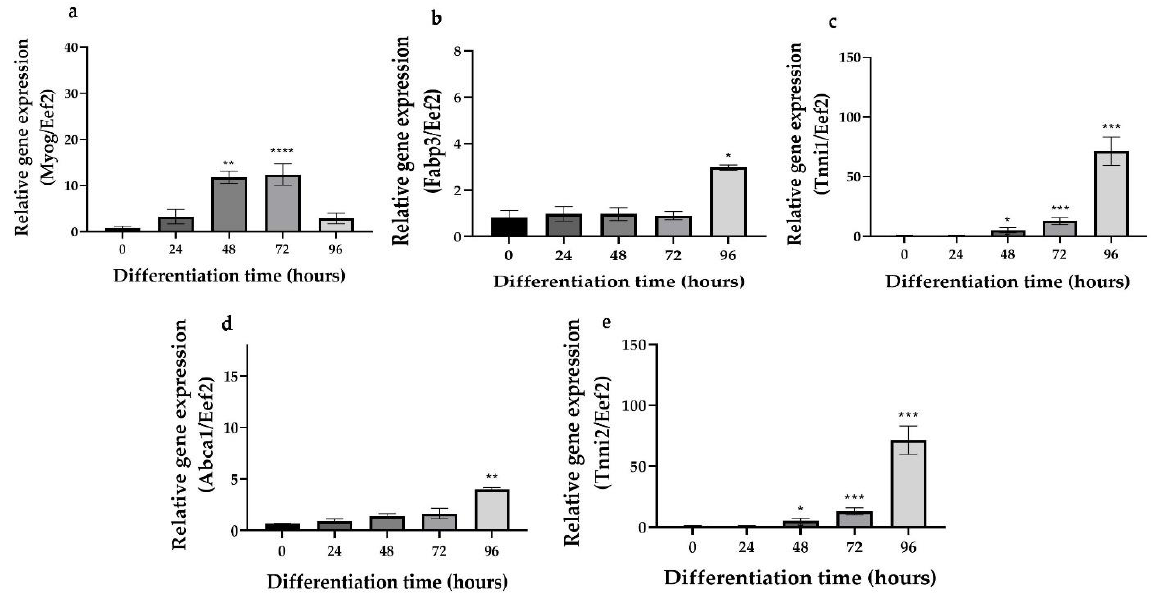
Figure 1. Gene expression of Myog, Tnni1 , Tnni2 , Abca1, and Fabp3 . ( a – e ). Quantitative real-time PCR mRNA expression of Myog , Tnni1 , Tnni2 , Abca1 , and Fabp3 respectively during the differentiation of C2C12 skeletal muscle cells. Data are presented as the mean ± SD of three independent repeats ( n = 3). * p < 0.05; ** p < 0.01; *** p < 0.001; **** p < 0.0001 indicate a significant difference between differentiated and the control groups.